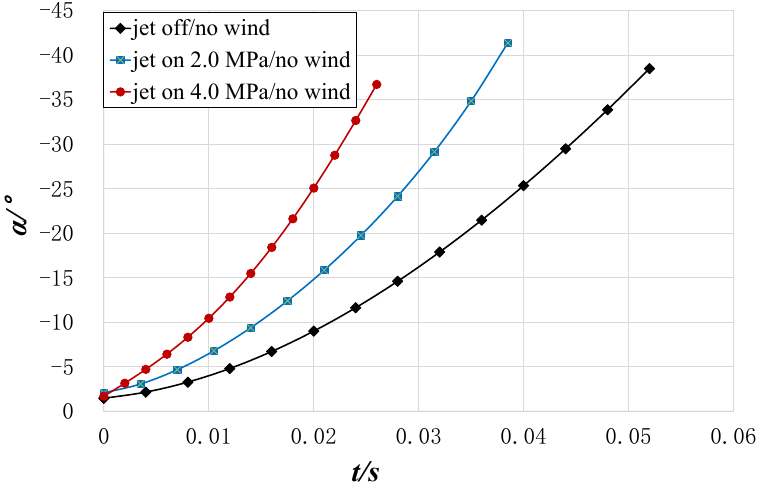
Figure 9. The revolution body pitch for no wind, with and without a jet.